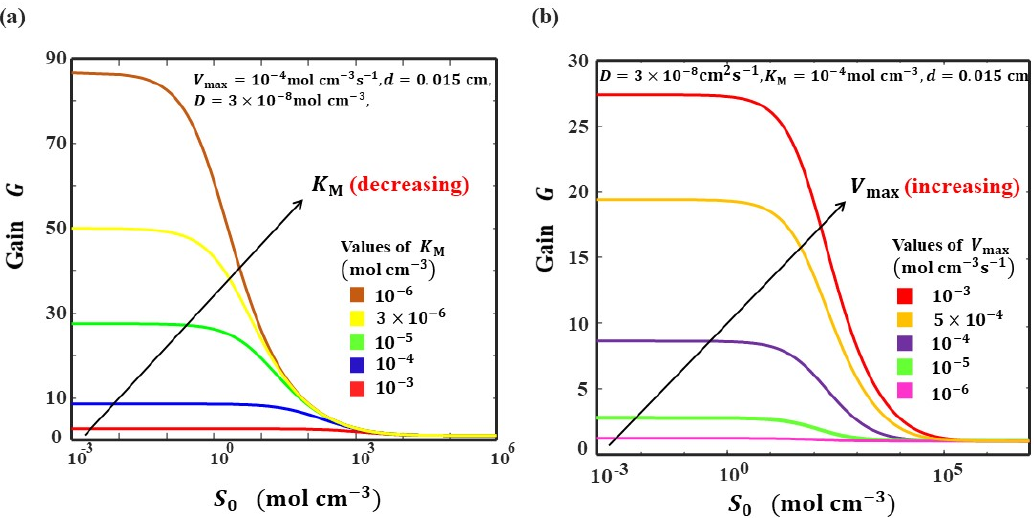
Figure 5. Plot illustrating the change in signal gain of biosensors with respect to the substrate concentration at the various values of ( a ) K M and ( b ) V max